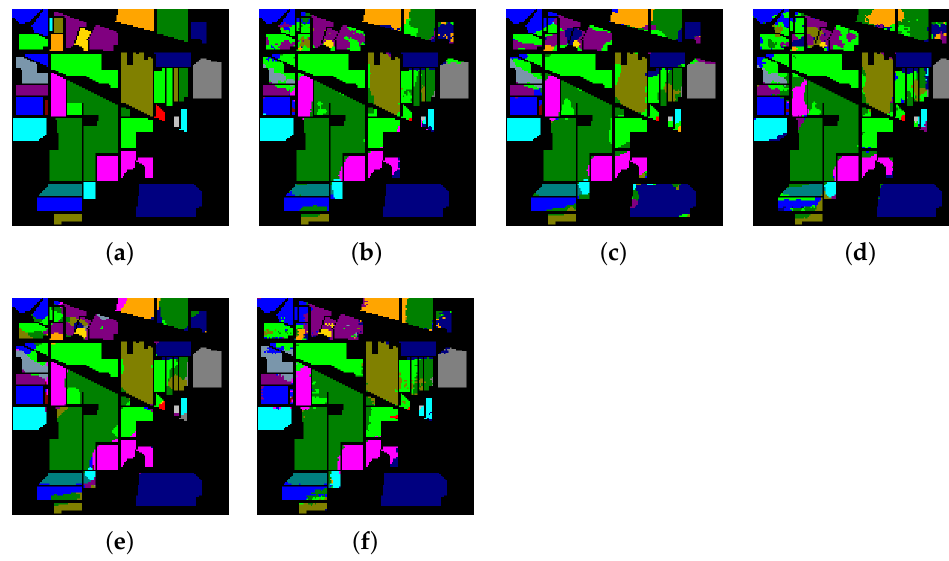
Figure 12. The classification maps of Indian Pines. ( a ) Ground-truth map. ( b )–( f ) Classification results of 2-D-convolutional neural network (CNN), 3-D-CNN, Multi-3-D-CNN, HybridSN, and